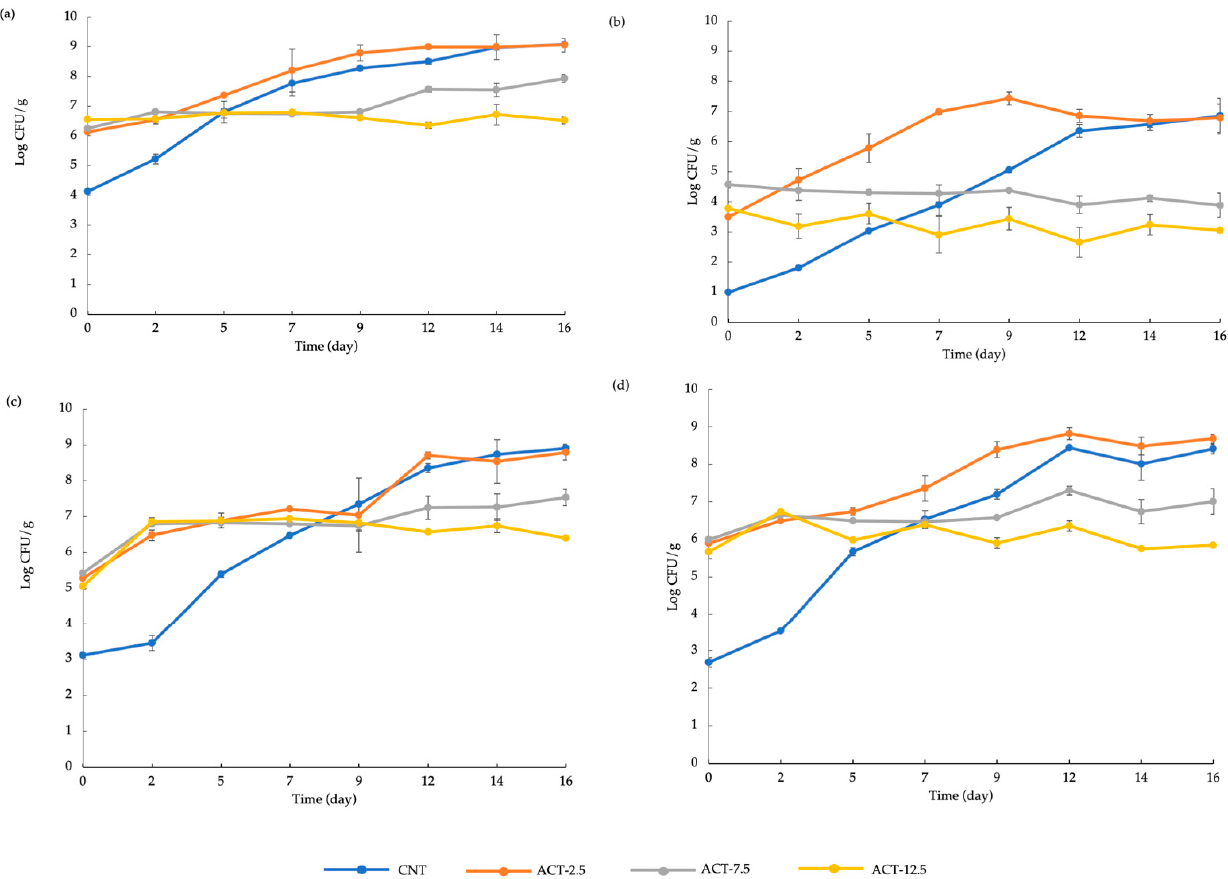
Figure 4. The evolution of total mesophilic bacteria ( a ) Enterobacteriaceae ( b ) Lactic acid bacteria ( c ) and Hydrogen Sulfide producing bacteria ( d ) in fish burgers during 16 days of storage at 4° C. Data indicate the mean ± SD. CNT: fish burger without prickly pear powder; ACT-2.5: fish burger enriched with 2.5 g of prickly pear powder; ACT-7.5: fish burger enriched with 7.5 g of prickly pear powder; ACT-12.5: fish burgers enriched with 12.5 g of prickly pear powder.